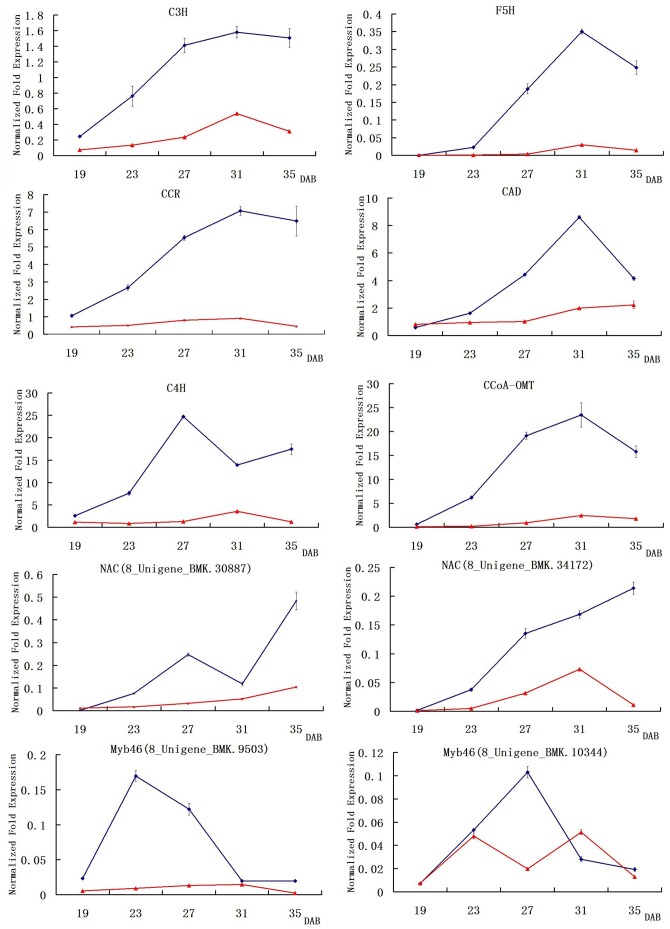
The expression levels of 6 lignin pathway genes (C3H, C4H, CAD, CCoA-OMT, CCR and F5H) and Myb46 and NAC genes using qRT-PCR.Blue lines mean the hard-endocarp hawthorn (H8), red lines mean the soft-endocarp hawthorn (S7). Y-axis represents normalized fold expression, X-axis is DAB (Days after bloom).